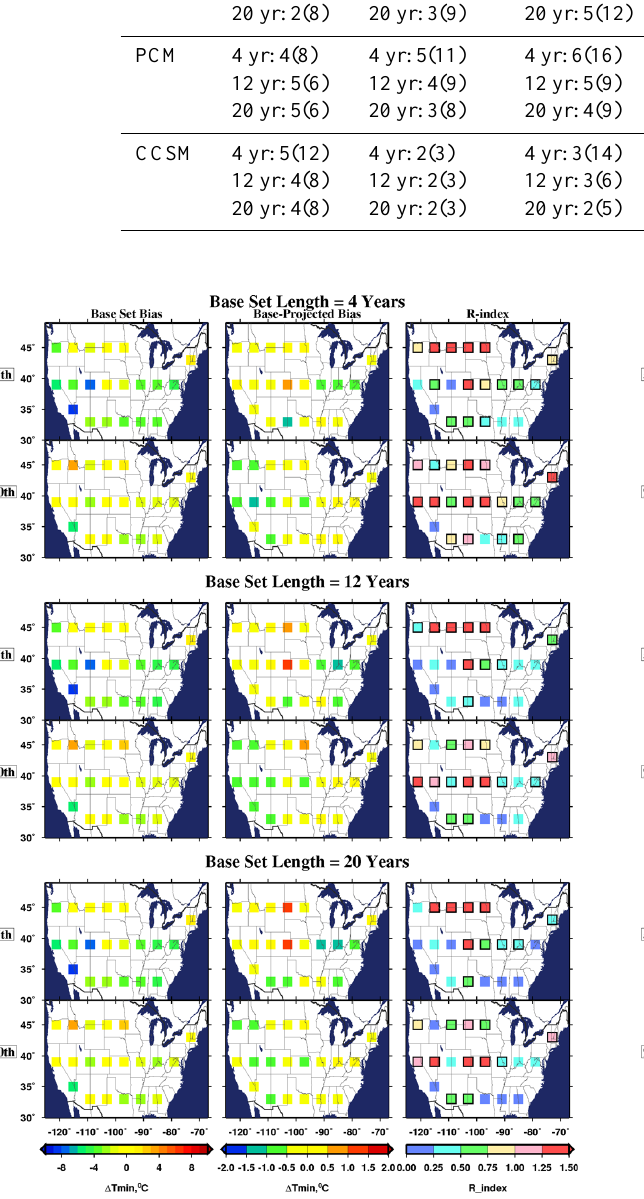
Fig. 4. Same as Fig. 3 but for DJF minimum daily temperature. Fig. 5. Same as Fig. 3, for DJF